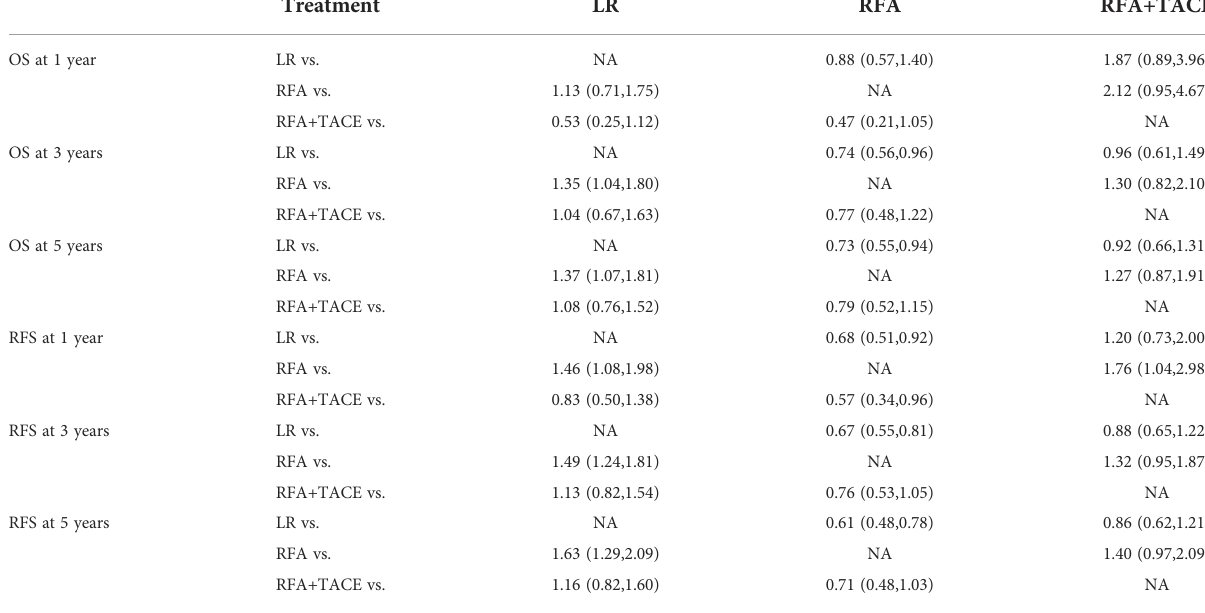
TABLE 2 Summary of all results.